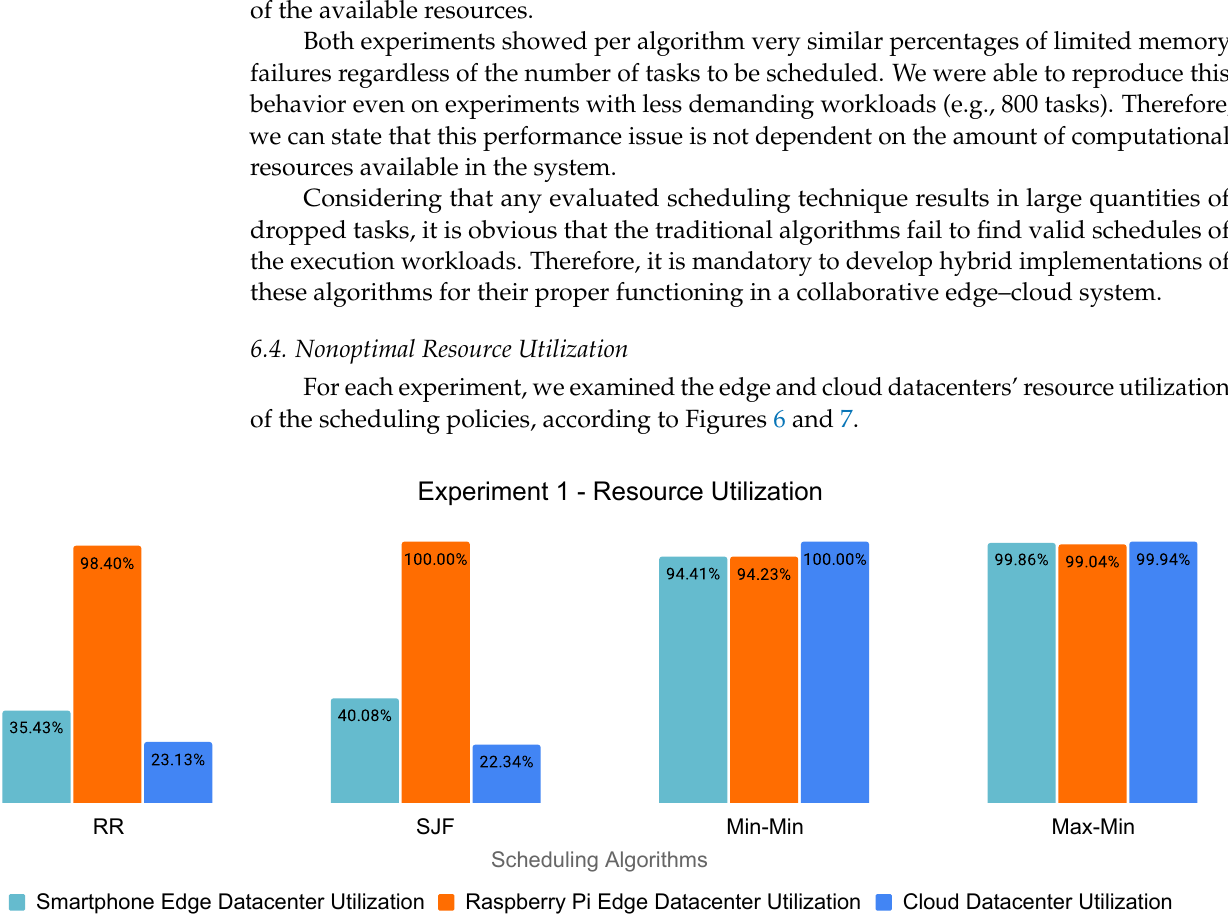
Figure 6. Datacenters’ resource utilization for Experiment 1 (2000 tasks).